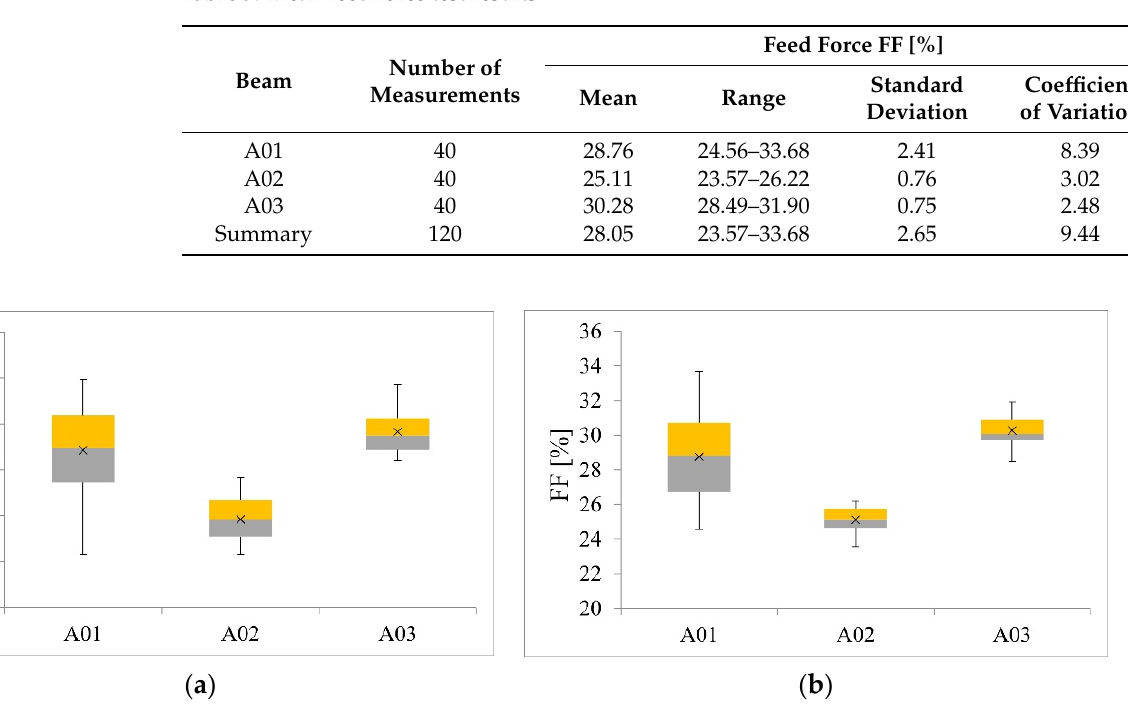
Figure 9. Box plots: ( a ) Resistance Measure–RM, ( b ) Feed Force–FF.